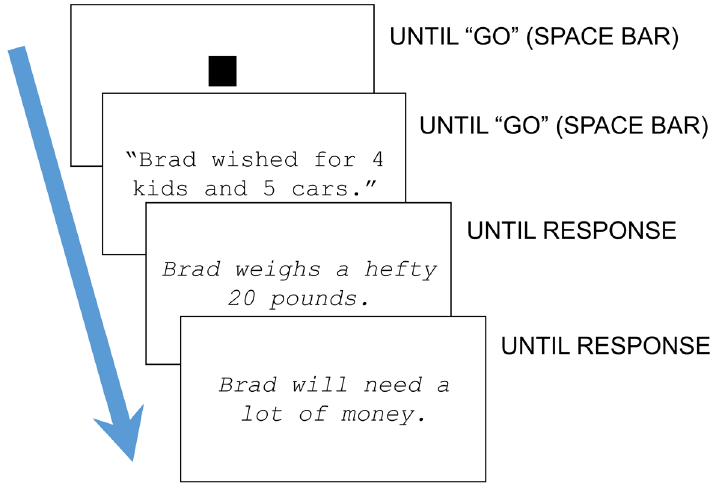
Figure 3. Illustration of the experimental procedure for the Sentence Verification